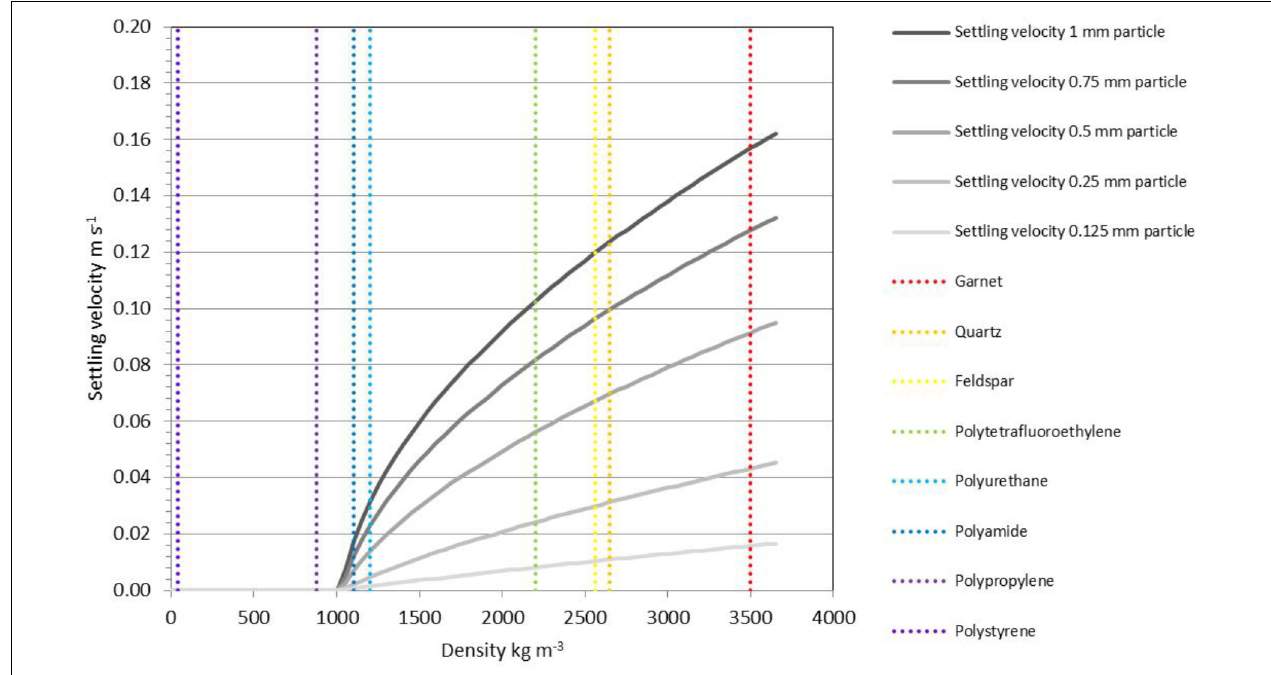
FIGURE 8 | Settling velocities estimated for a range of spherical particles in a turbulent flow; as an example a 1 mm polyurethane sphere would settle at similar velocity to a 0.25 mm quartz grain. Natural particles have a wide range of shapes and surface roughness which will affect their settling, and microfibers will diverge significantly from this